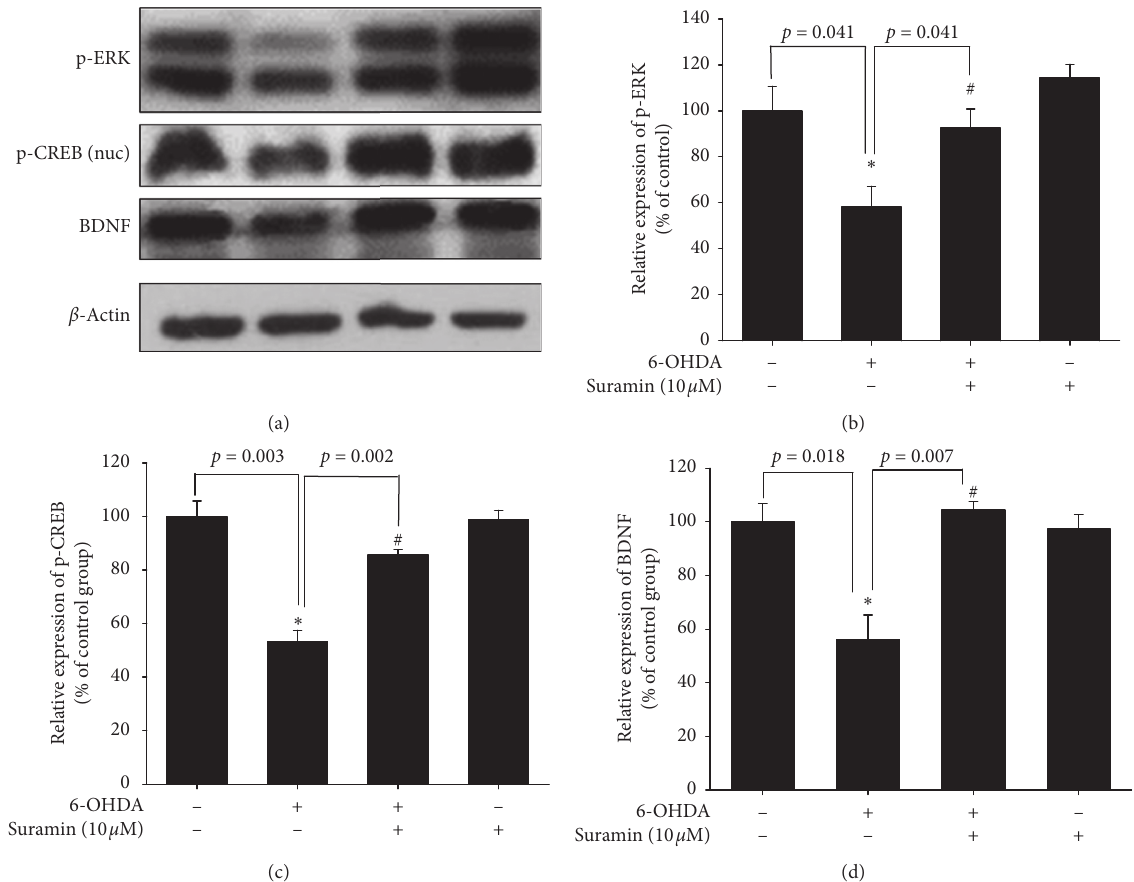
Figure 3: Effect of suramin on 6-OHDA-induced downregulation of phospho-extracellular signal-regulated kinases (p-ERK), phospho- cAMP response element-binding protein (CREB), and brain-derived neurotrophic factor (BDNF) in SH-SY5Y cells. (a) SH-SY5Y cells were pretreated with 10 μ M suramin for 1 h and then challenged with 20 μ M 6-OHDA for 1 h; western blotting for p-ERK and p-CREB of the control, 6-OHDA, 6-OHDA plus suramin, and suramin alone groups is shown. SH-SY5Y cells were pretreated with 10 μ M suramin for 1h and then challenged with 20 μ M 6-OHDA for 8h; western blotting for BDNF of the control, 6-OHDA, 6-OHDA plus suramin, and suramin alone groups is shown. β -Actin was used as an internal control. (b) The quantification results of p-ERK relative density are shown. (c) The quantification results of p-CREB relative density are shown. (d) The quantification results of p-ERK relative density are shown. Data are presented as mean ± SEM, and each value contains three replicates and three samples. ∗ Significantly different from the control group; # significantly different from the 6-OHDA